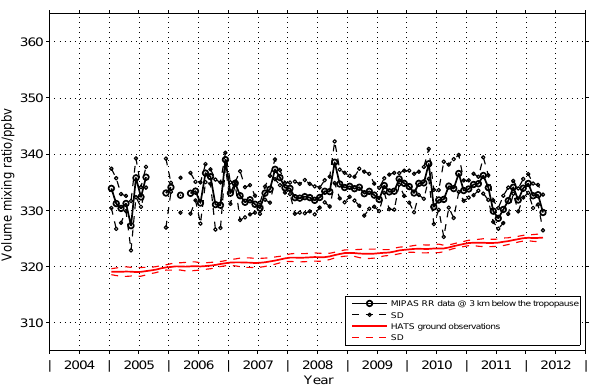
Figure 9. Comparison of CH 4 from ACE-FTS and MIPAS full res- olution (V5H_CH4_21). Details as in Fig. 1.